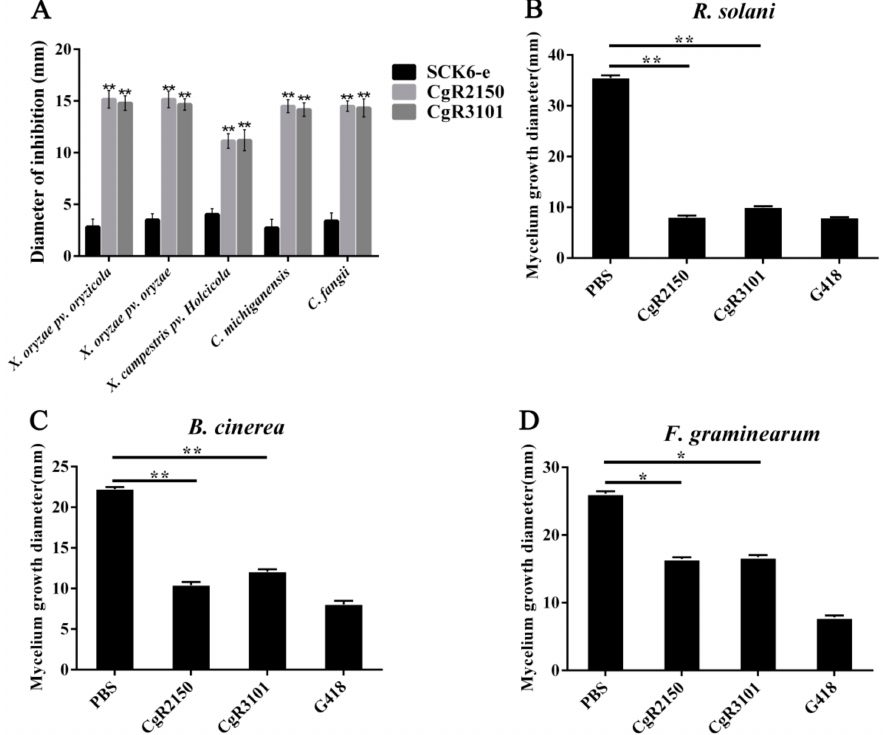
Figure 5. Determination of antimicrobial activities of two resistant genes against pathogenic bacteria and fungi. The B. subtilis SCK6-e strain was used as a control to determine the inhibitory effects of the peptides on pathogenic bacteria. Phosphate buffered saline (PBS) was used as a negative control, and geneticin (G418) was used as a positive control to detect the inhibitory activities of the peptides against pathogenic fungi. ( A ) Inhibitory effects of peptides CgR2150 and CgR3101 on five tested strains compared with SCK6-e. ( B ) Inhibitory activities of peptides CgR2150 and CgR3101 on R. solani hyphae compared to PBS buffer. ( C ) Inhibitory effects of peptides CgR2150 and CgR3101 on B. cinerea hyphae. ( D ) Inhibitory activities of peptides CgR2150 and CgR3101 on F. graminearum hyphae. The data are the mean values obtained after three independent experiments, and the vertical bars are the standard deviations (SD). Significance analysis was performed by t -test; * p < 0.05, ** p <